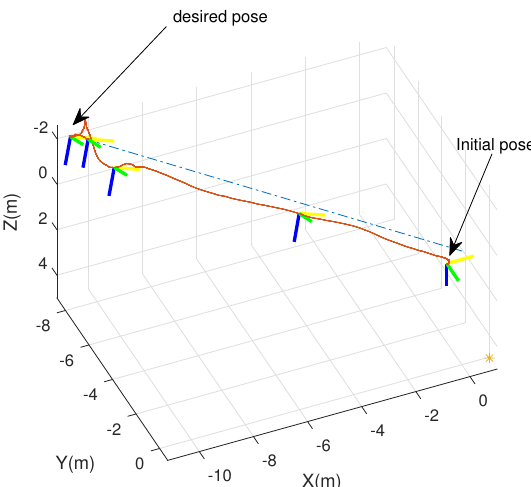
Figure 9. Position and attitude profiles tracked during real-world flight test. Note the big initial error here. A typical PID is difficult to stabilize the IAP in such condition as the controller may output large action which violates the input boundedness. In contrast, our proposed control scheme successfully stabilizes the system as it can deal with the state and input constraints.